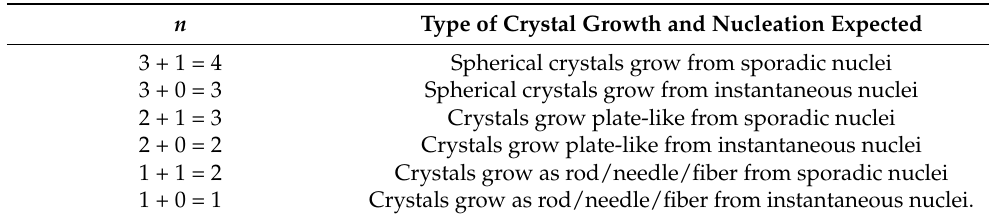
Table 1. Values for the Avrami index, n , for different types of nucleation and growth. n Type of Crystal Growth and Nucleation Expected 3 + 1 = 4 Spherical crystals grow from sporadic nuclei 3 + 0 = 3 Spherical crystals grow from instantaneous nuclei 2 + 1 = 3 Crystals grow plate-like from sporadic nuclei 2 + 0 = 2 Crystals grow plate-like from instantaneous nuclei 1 + 1 = 2 Crystals grow as rod/needle/fiber from sporadic nuclei 1 + 0 = 1 Crystals grow as rod/needle/fiber from instantaneous